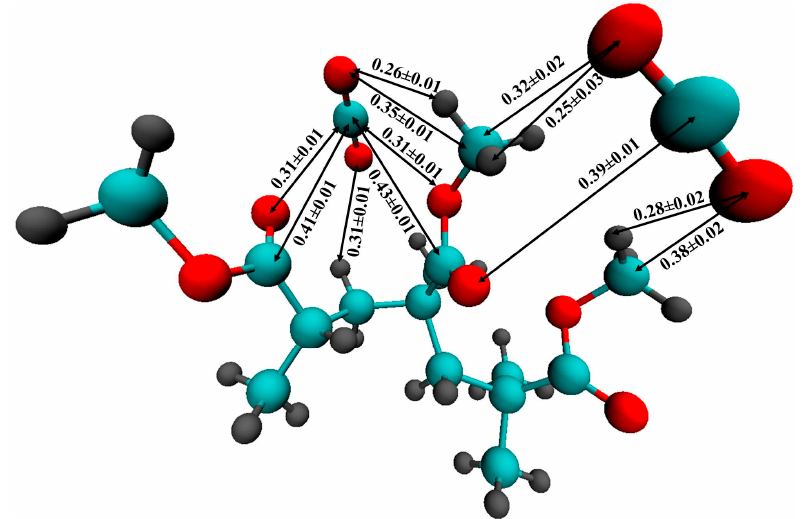
Figure 10. The complex of a PMMA fragment with two CO 2 molecules according to the CPMD. All the distances are given in nm. The averaging of the distances was made over the last 120 fs. (The red spheres denote the oxygen atoms, the gray ones represent the hydrogen atoms, the cyan ones represent the carbon atoms.).